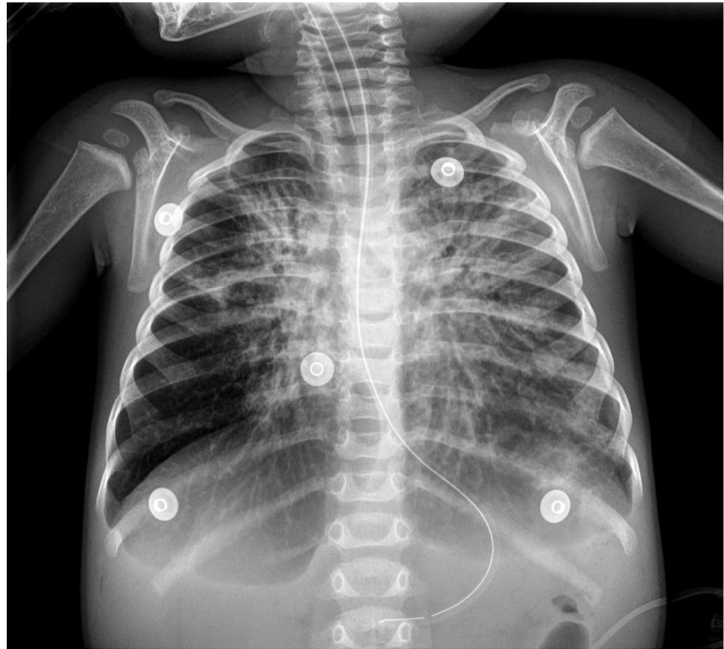
Figure 2. Initial chest radiography with bilateral alveolar infiltrates and tissular pattern in left lung suggesting consolidation.